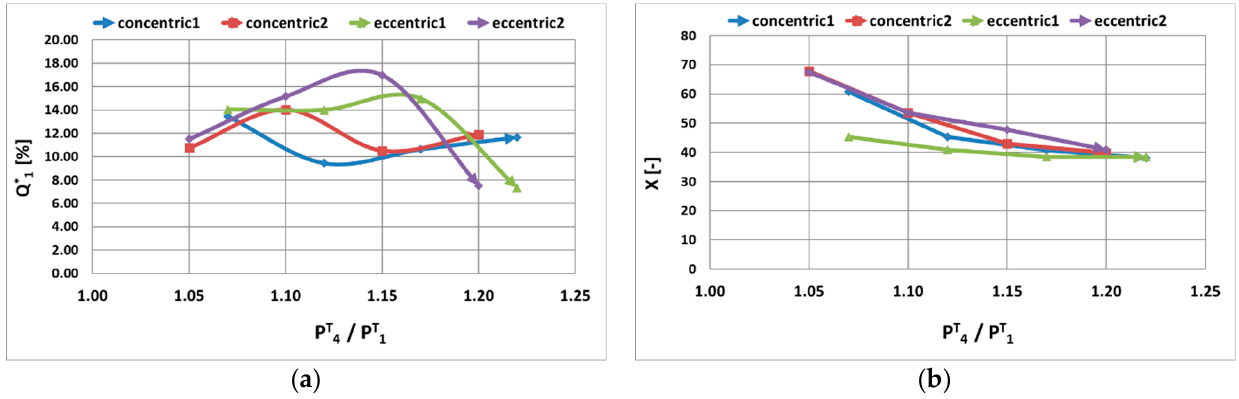
Figure 21. ( a , b ) Single-phase Eccentric Jet pump vs. Concentric Jet pump Case of study Quifa Field. Compared against a single loop, Figure 9a, total flow rate increment refereed to